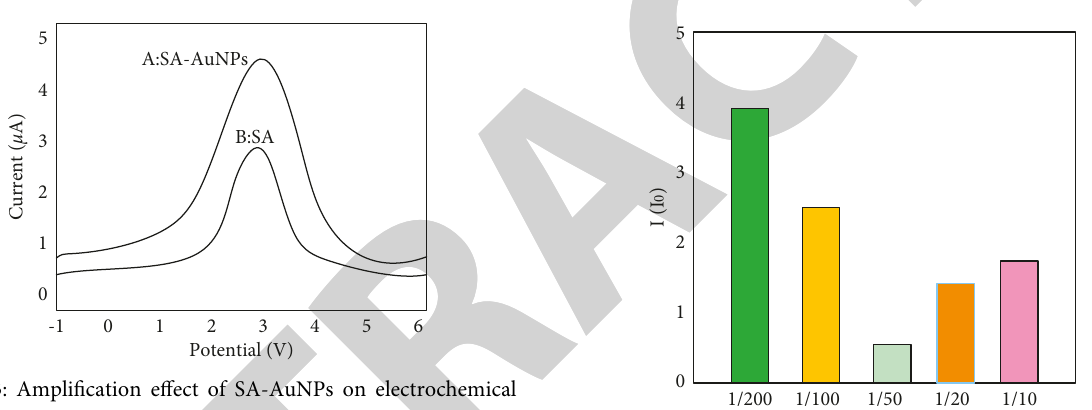
Figure 5: Effect of SA-AuNPs concentration on the analytical performance of the sensor.